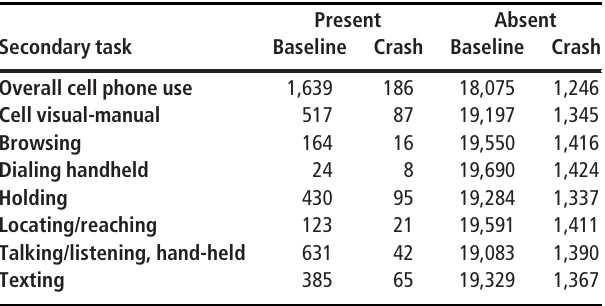
Table III The numbers of crashes and baseline epochs where each cell